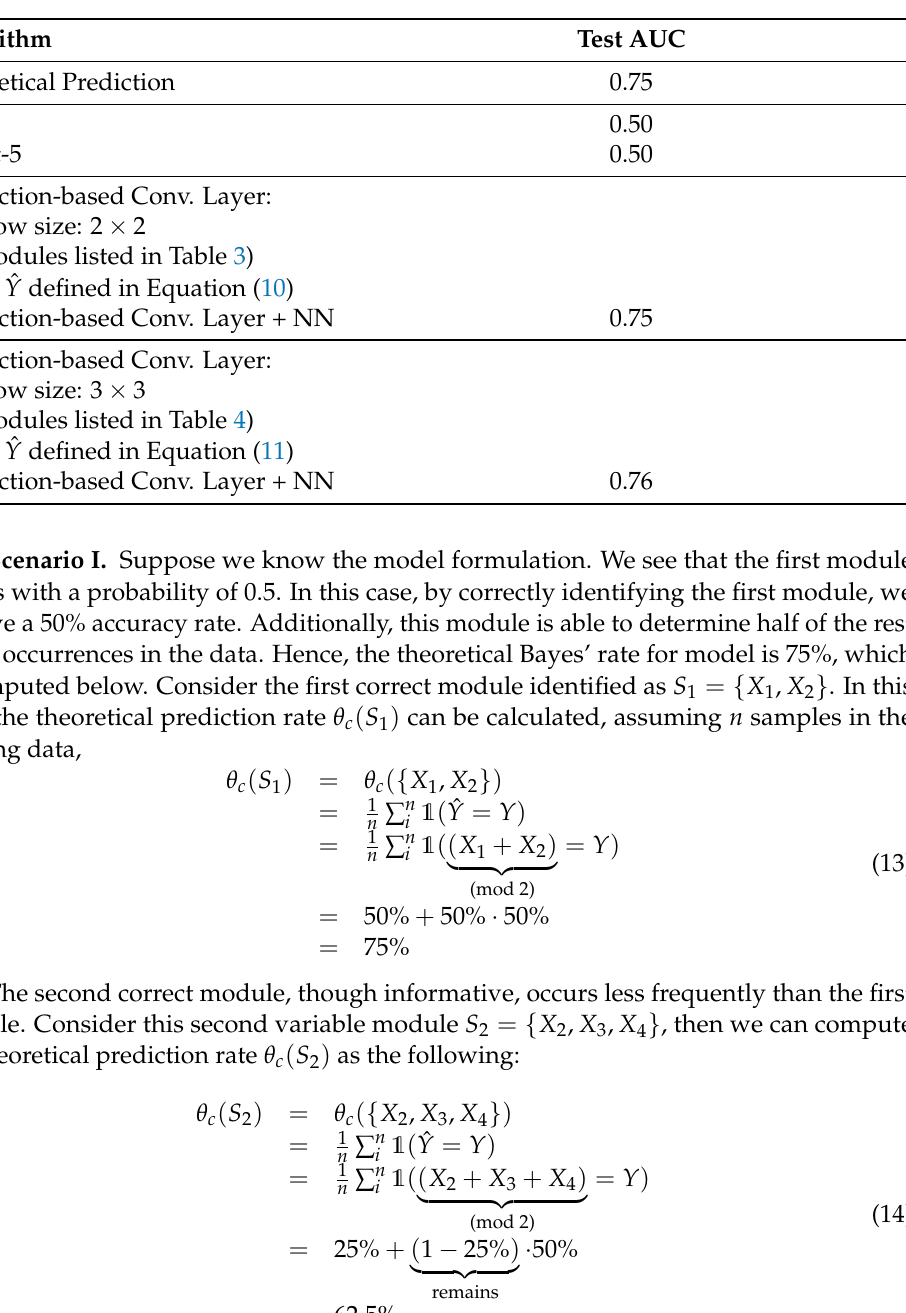
Table 5. The performance of a simulation. In this simulation, we defined the underlying model to be (7). The theoretical prediction rate is 75%. A conventional model such as Net-3 and LeNet-5 does not perform well in this example [28,29]. The proposed method that uses the I-score has prediction performance that is close to the theoretical prediction rate (see Section 4.4 for a detailed discussion of AUC values). NN, neural network. This is discussed in Section 4.2 and please review the architecture in Figure 5 for a detailed